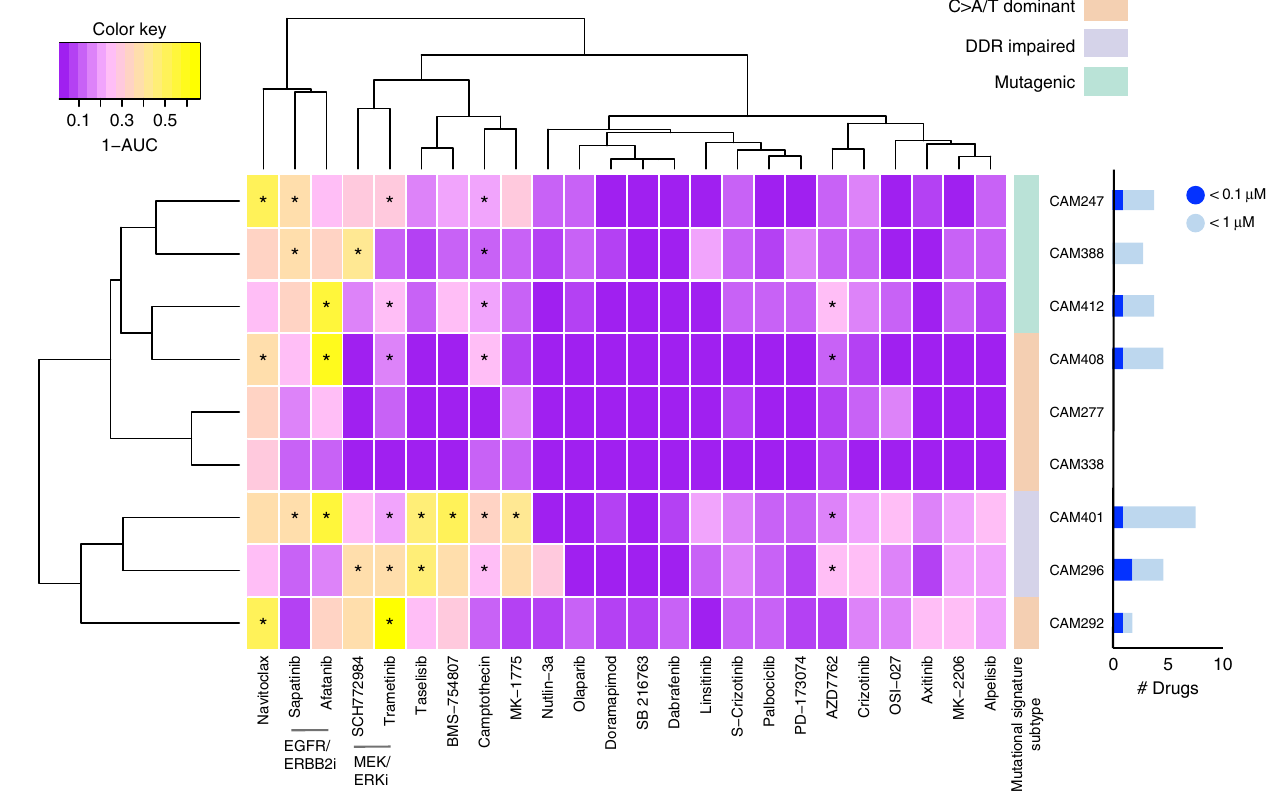
Fig. 6 Drug sensitivity pro fi ling of 24 compounds against nine EAC organoids. Organoid cultures are clustered based on their drug sensitivity as measured by 1-AUC values across the drug panel. The drug names are provided at the bottom of the panel and the mutational signature subtype also indicated. Asterisks (*) identify drugs that elicited an IC 50 below 1 µ M while the histogram indicates the number of drugs for each organoid culture eliciting an IC 50 below 1 or 0.1 μ